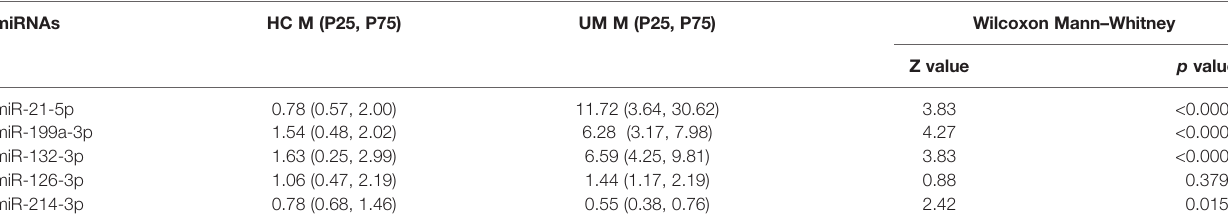
TABLE 4 | The normalized serum levels of miRNAs in UM patients and healthy controls.